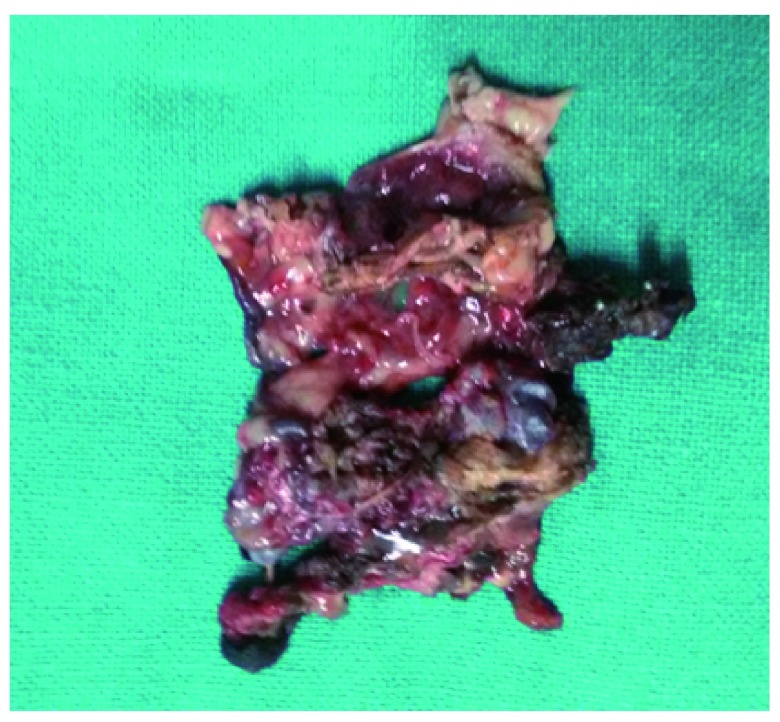
Excised AVM nidus.